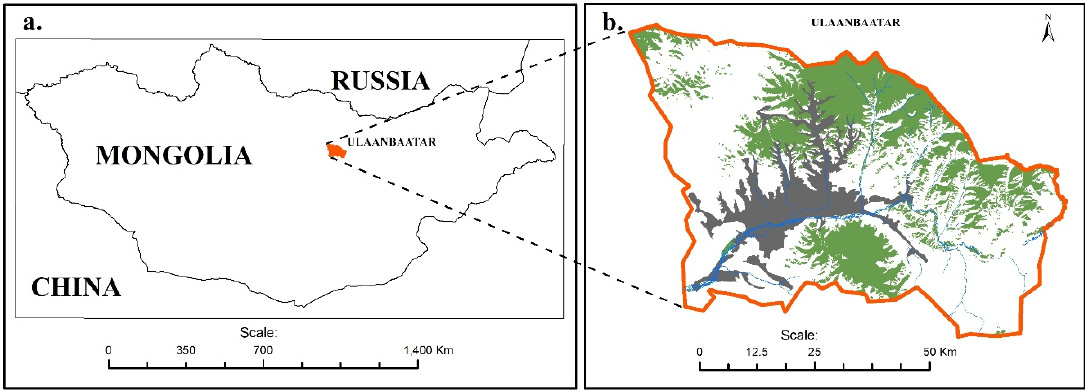
Figure 1. Map over the study area. ( a ) Location of Ulaanbaatar; ( b ) map with forest, river and urban areas (grey = built-up area; green = forest; blue = river).